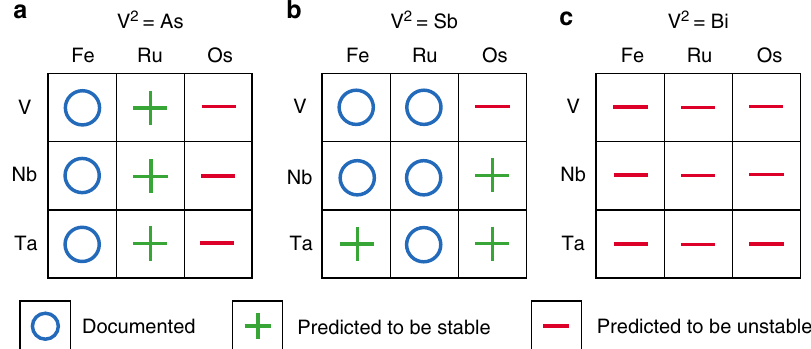
Fig. 1 Thermodynamic stability calculation. Calculated stability of the V 1 -VIII-V 2 family (with V 1 = V, Nb, and Ta; VIII = Fe, Ru, and Os; and V 2 = As, Sb, and Bi) of half-Heusler compounds. a V 1 -VIII-As, b V 1 -VIII-Sb, and c V 1 -VIII-Bi